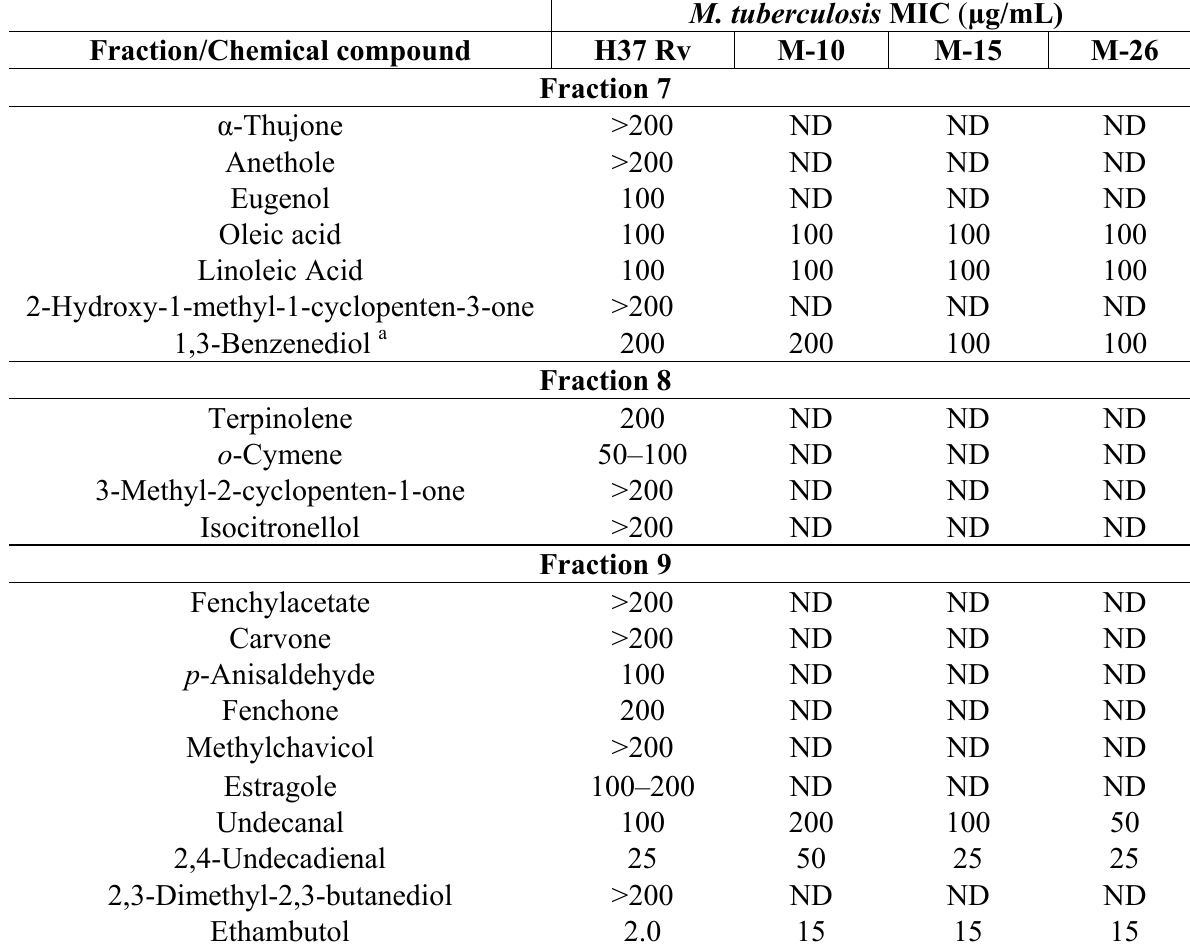
Table 4. Antimycobacterial activity of some compounds from F . vulgare